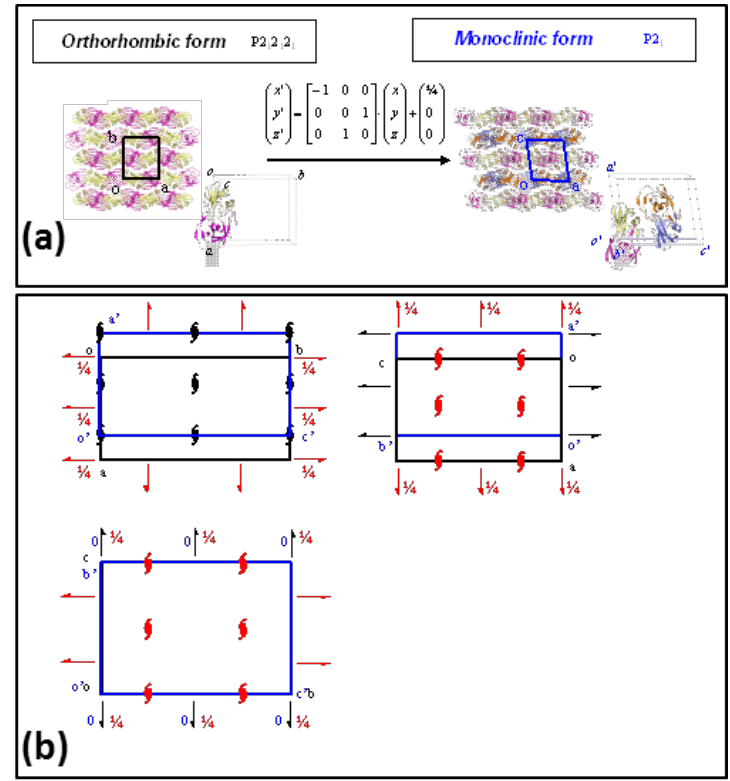
Figure 4. Group/subgroup relations in PR/EPX crystal forms. ( a ) Transformation of the asymmetric orthorhombic form (space group P2 1 2 1 2 1 ) in that of monoclinic form (space group P2 1 ). The transformation matrix and the translation vector of the atomic coordinates are also reported; ( b ) Superposition of the P2 1 2 1 2 1 space-group diagram of the orthorhombic form (black) with the space-group diagram of the maximal non-isomorphic sub-groups P2 1 of the monoclinic form (blue) shows the origin shift (1/4, 0, 0), the axes swapping ( − a, c, b) and the missing symmetry operators (red symbols) to transform the lattice of orthorhombic form to that of monoclinic form.